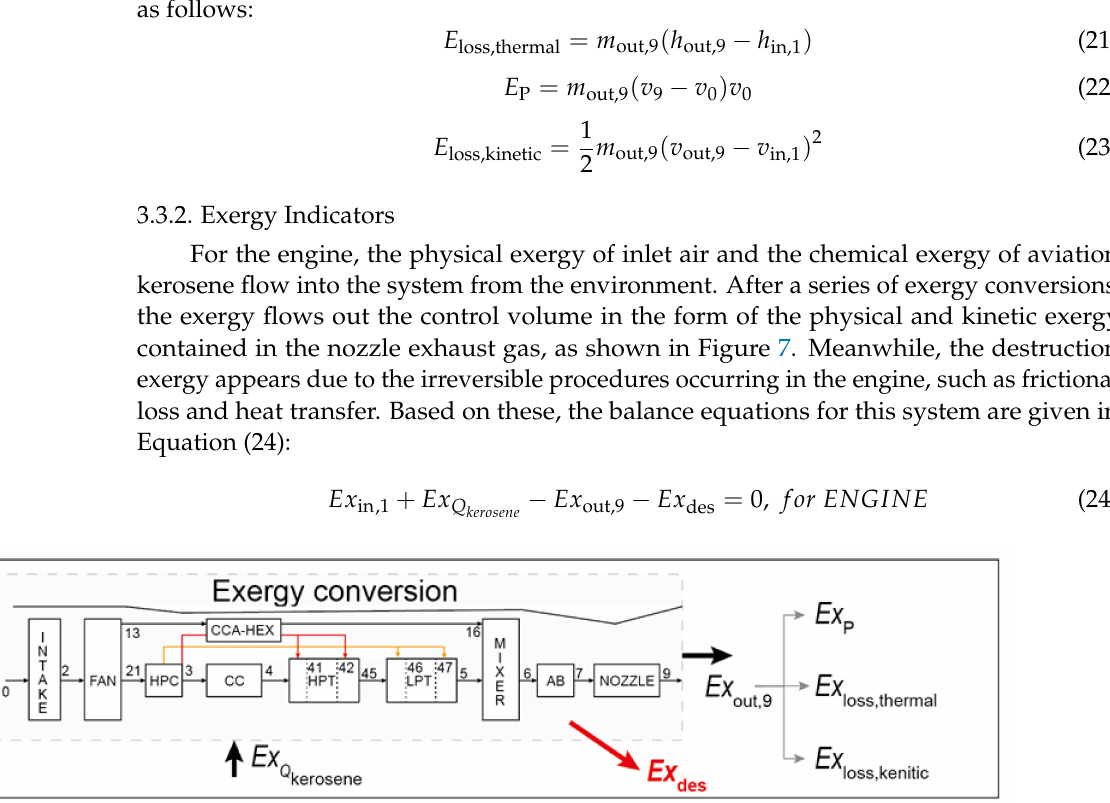
Figure 7. The control volume of energy